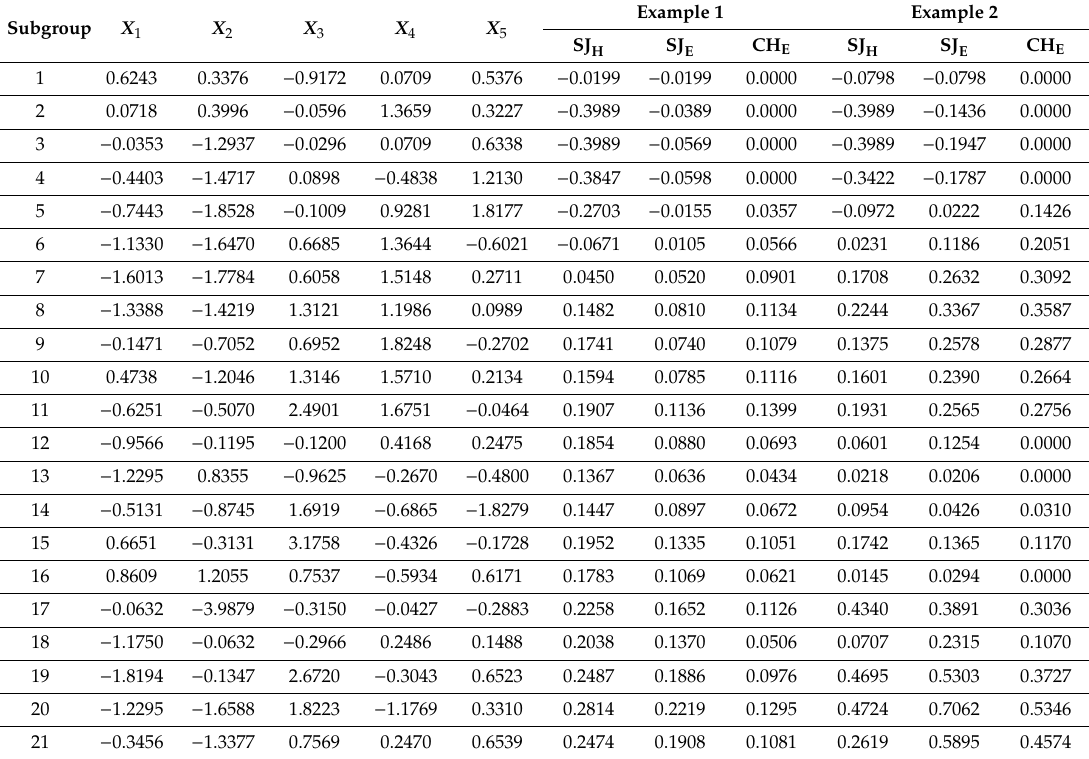
Table 4. The description of the wind farm data along with the plotting statistics of SJ H , SJ E , and CH E